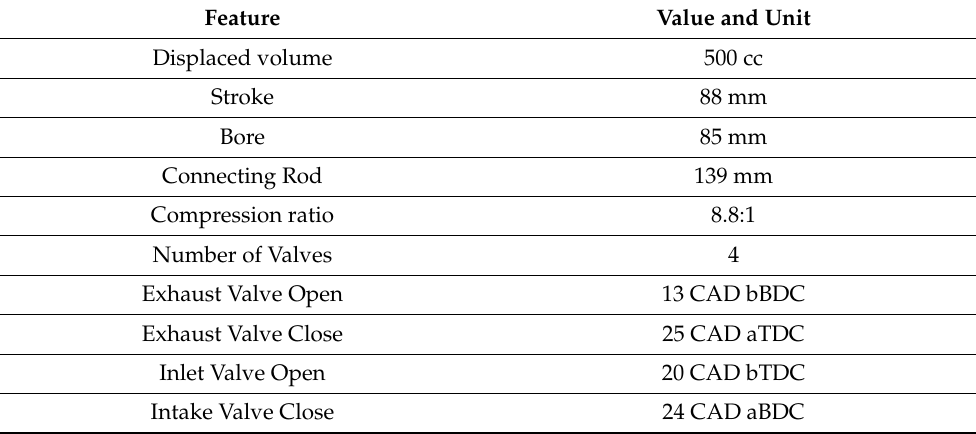
Figure 1. The main components of the optical access engine; focus on the optical configuration, which allows acquisition of the flame front evolution inside the combustion chamber. Table 1. Optical access engine